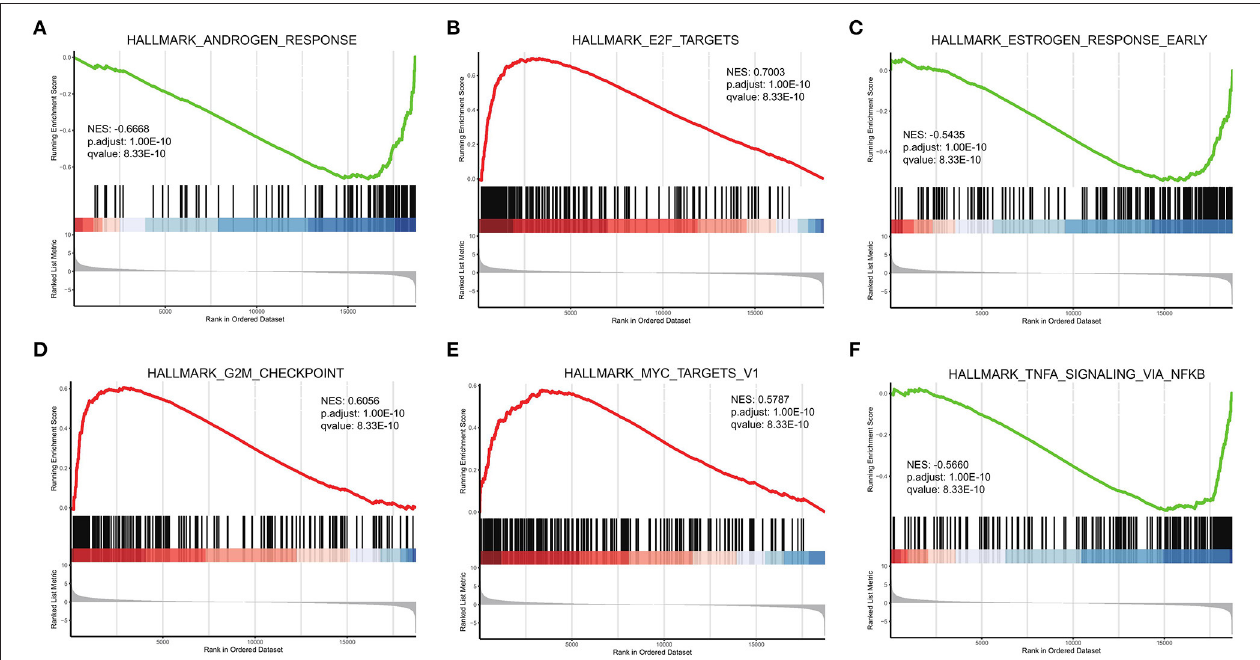
FIGURE 6 | GSEA of high- and low-risk groups. (A–F) Top six results for high- and low-risk gene